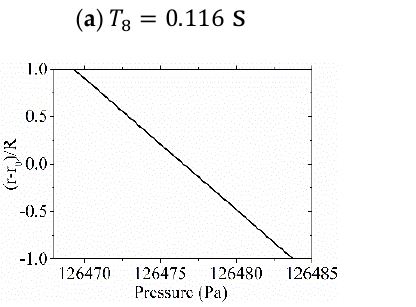
Figure 20. Local pressure distribution at S1 monitoring position of different time ( 𝑇 8 = 0.116 s and 𝑇 9 = 0.124 s ).